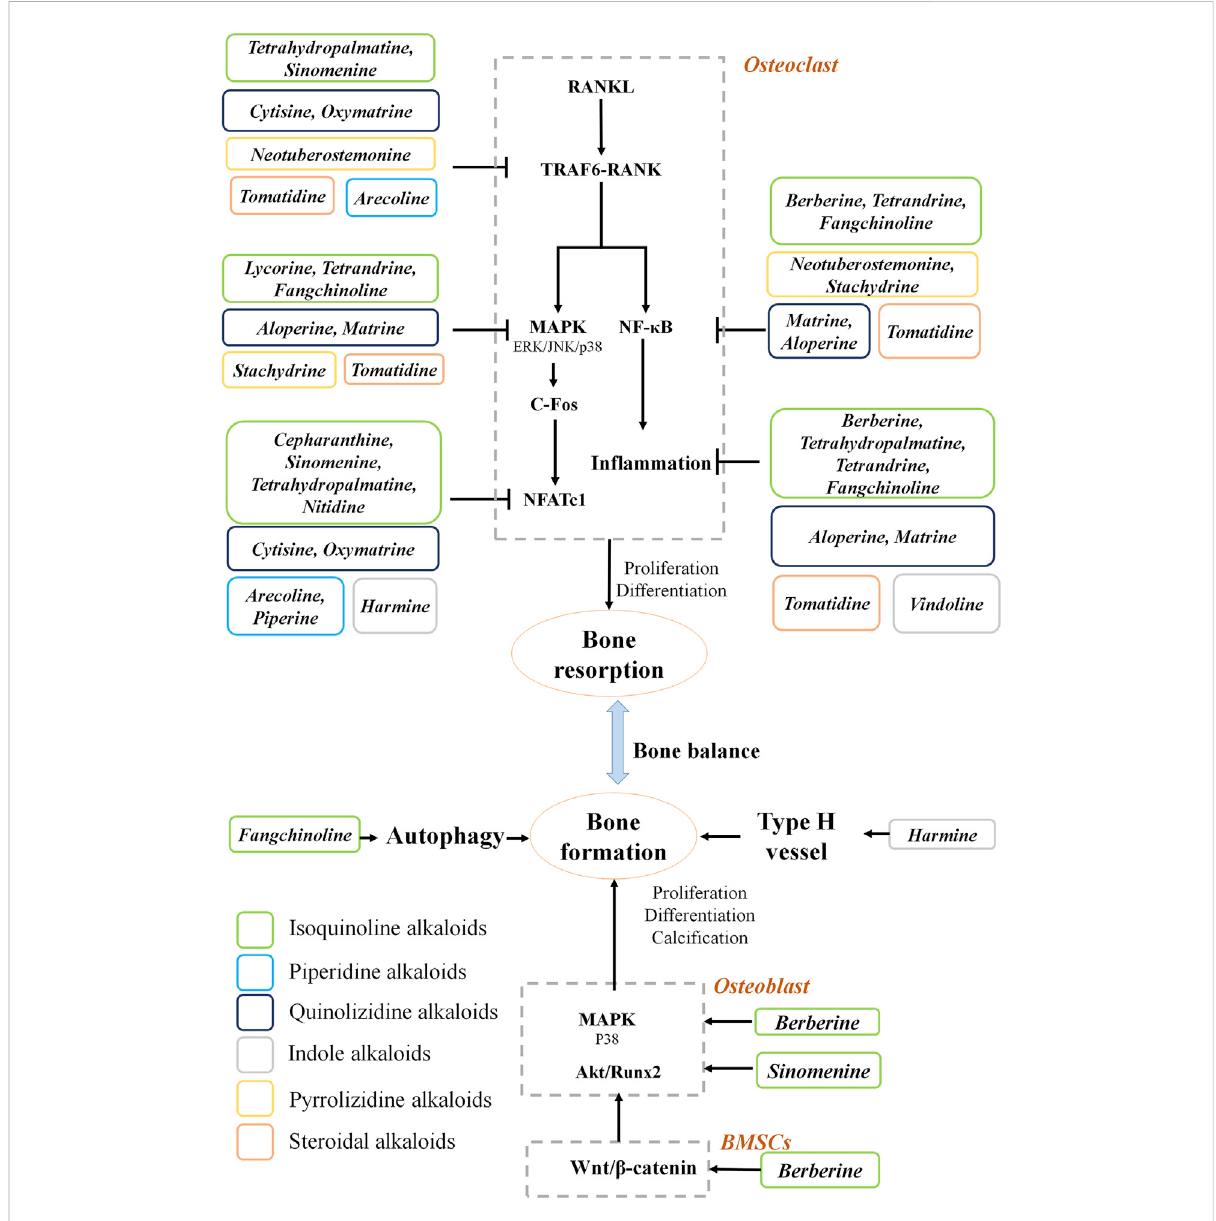
Mechanism of natural alkaloids for preventing and treating